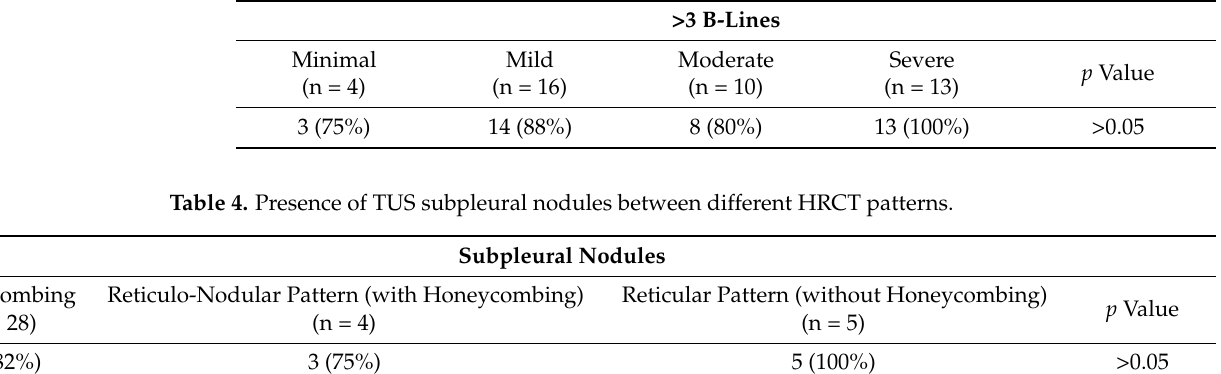
Table 3. Presence of >3 B ‐ lines between different degrees of fibrosis.